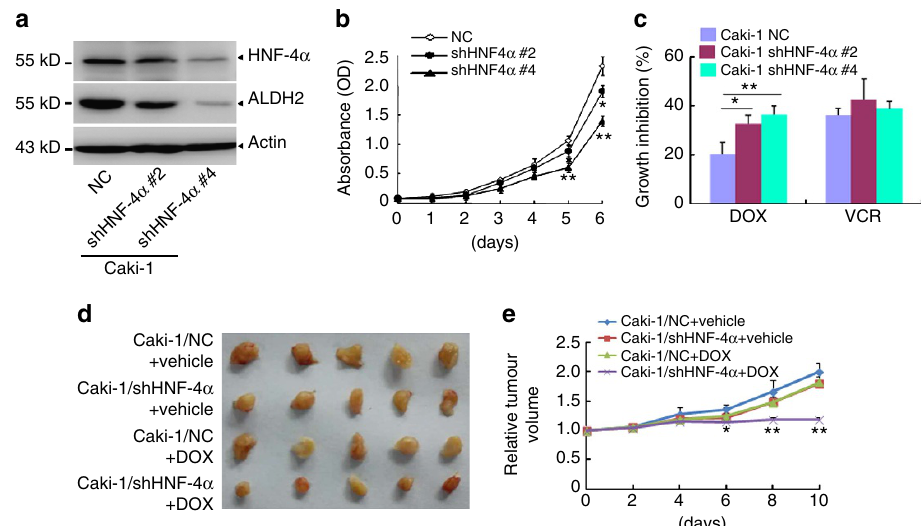
Figure 9 | HNF-4 a regulates cytotoxicity of anthracyclines in ccRCC. ( a ) Caki-1 cells were stably transfected retroviral vectors harbouring shRNA against HNF-4 a (#2 and #4) or non-specific control (NC). Then the indicated proteins were detected by western blot. ( b ) Growth curves of the indicated cells. ( c ) The indicated cells were treated with 1 m M doxorubicin for 24h and the growth inhibition rates were detected. ( d , e ) All indicated cells (5 (cid:3) 10 6 ) were injected into nude mice. Tumour-bearing mice were treated every 2 days with vehicle or with 4mg per kg doxorubicin by intraperitoneal injection. Five tumours per condition were analysed. ( d ) Pictures of tumours in nude mice injected with the indicated cells. ( e ) Relative tumour volume growth. Data are mean ± s.d. ( n ¼ 5 for each group). (* P o 0.05, ** P o 0.01 for t -test).